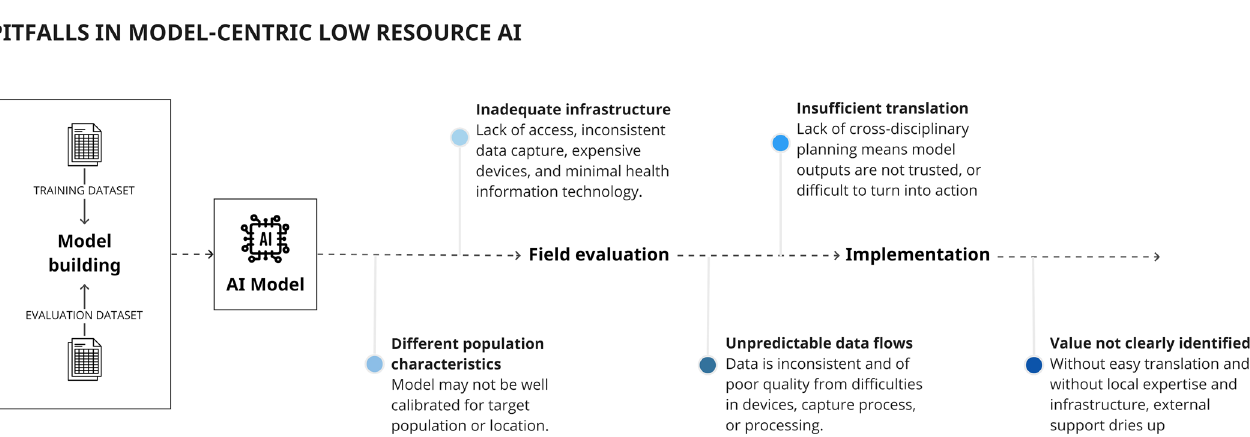
Fig. 4 Pitfalls in implementing models speci fi c to lower resource environments. AI models may be trained in high-resource academic labs, and taken to low-resource environments where they fail for the reasons illustrated. A model-centric approach that does not consider real- world supply chain components is unlikely to be successful.